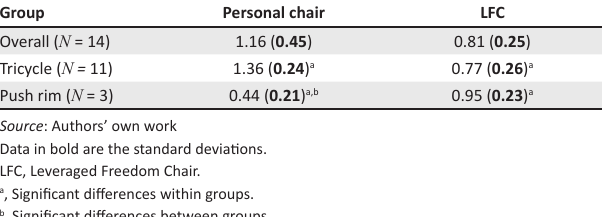
TABLE 4: Average propulsion efficiency (metres per cycle) during WPT (SD).